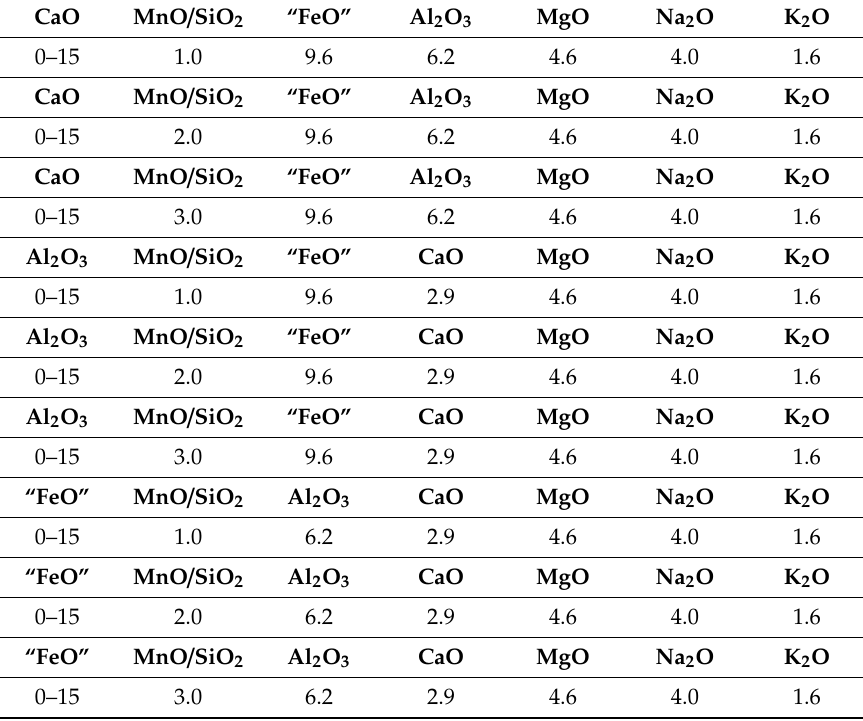
Figure 3. The effect of weight percent of SiO 2 per 100 g nodules added as a flux on the liquidus temperature at a fixed ratio of other components. Table 2. The composition of the slag used for FactSage calculation (wt%).